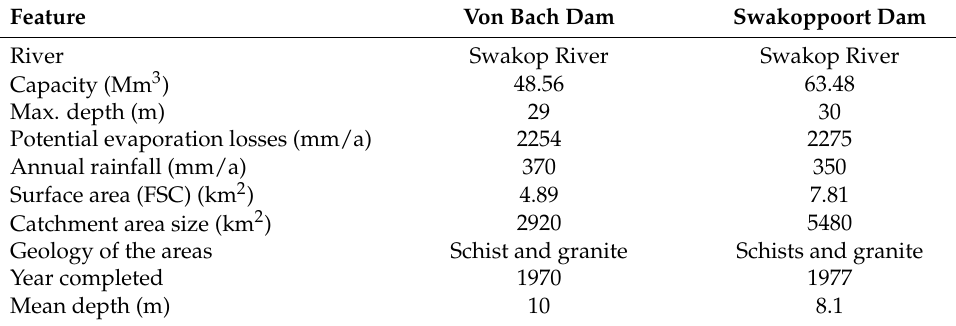
Table 1. The main features of the Swakoppoort and Von Bach dams.